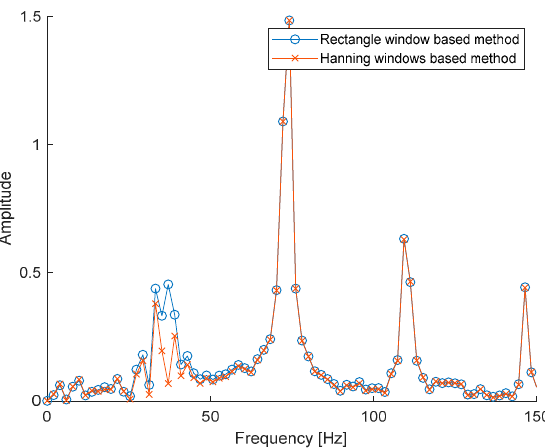
Figure 18. FFT spectrum of residual signals after reducing the sinusoidal wave related to SWF.